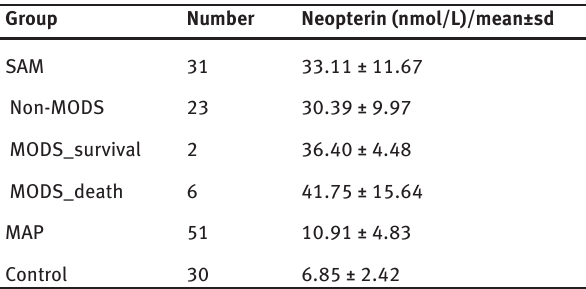
Table 1: Serum neopterin concentration comparison between